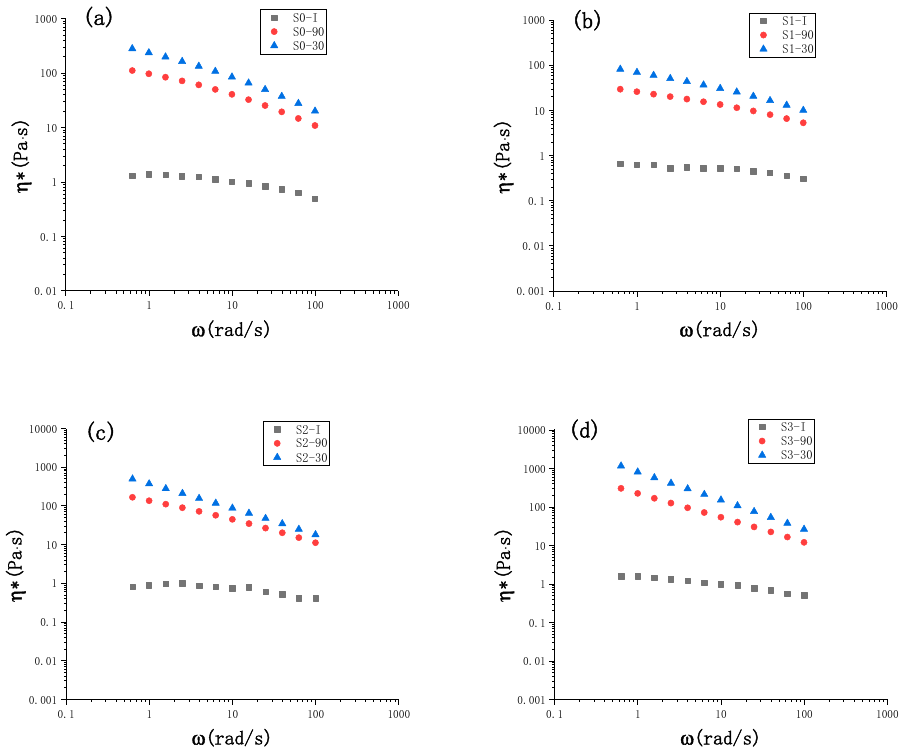
Figure 4. Complex viscosity of ( a ) S0, ( b ) S1, ( c ) S2, ( d ) S3 film-forming solutions dried to different water content.